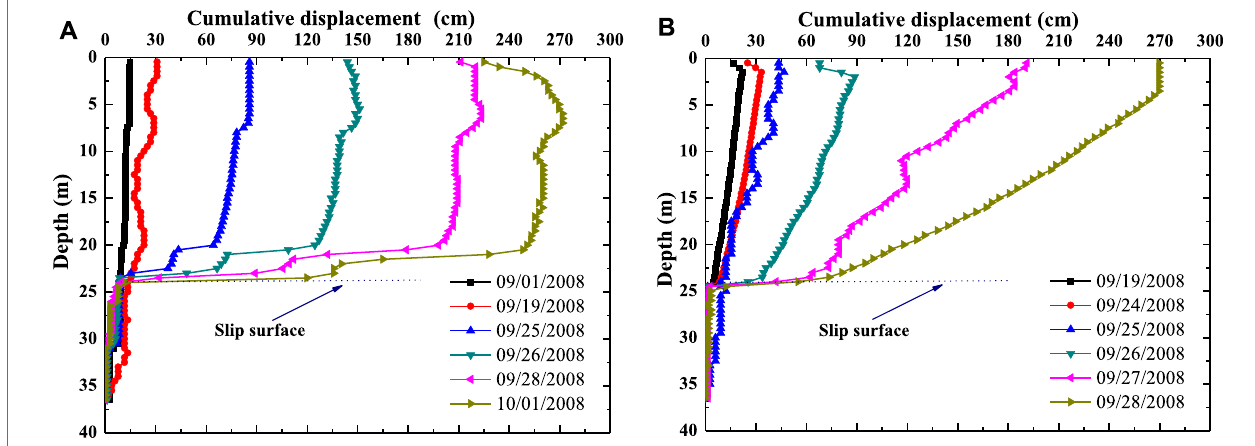
FIGURE 5 | Relationships between cumulative displacement and depth at different times measured by (A) 4# SAA and (B) 5# SAA (Modi fi ed from Dasenbrock, 2010; Danisch, 2015.)